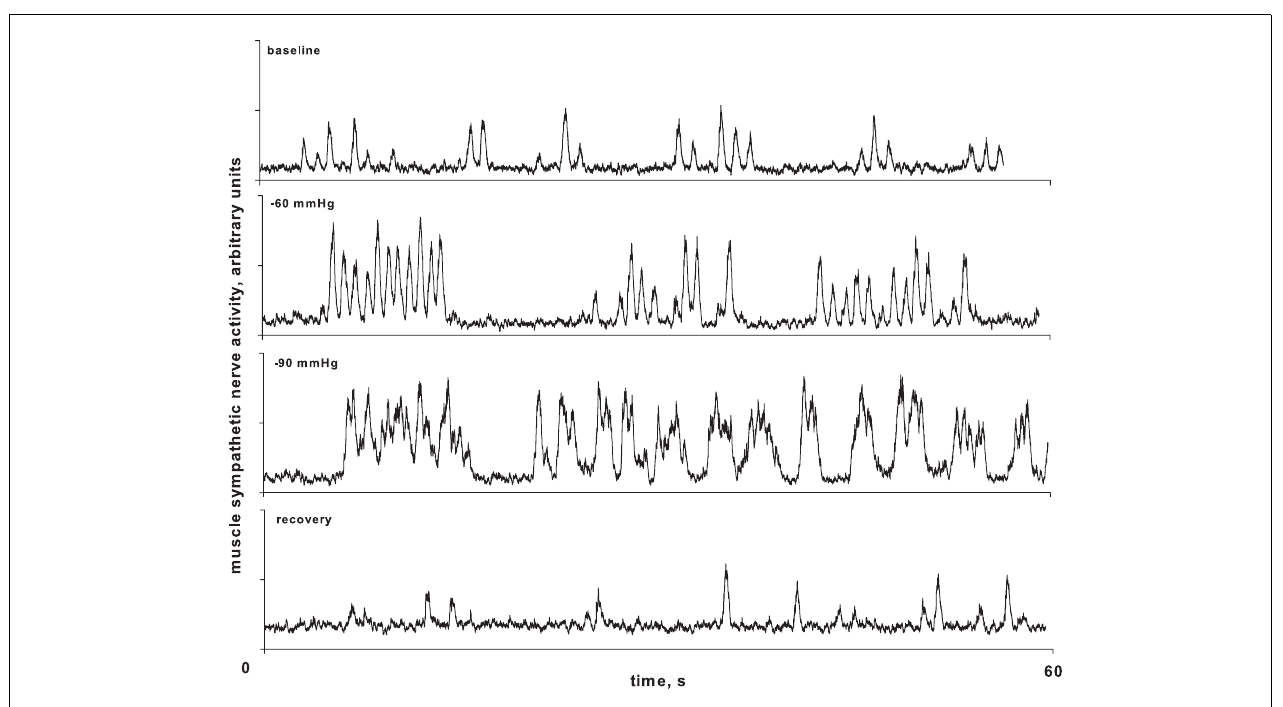
FIGURE 4 | Coupling ( − 60mmHg) and then fusing ( − 90mmHg) of muscle sympathetic nerve activity (MSNA) in one subject during lower body negative pressure. From Cooke et al. (2009).